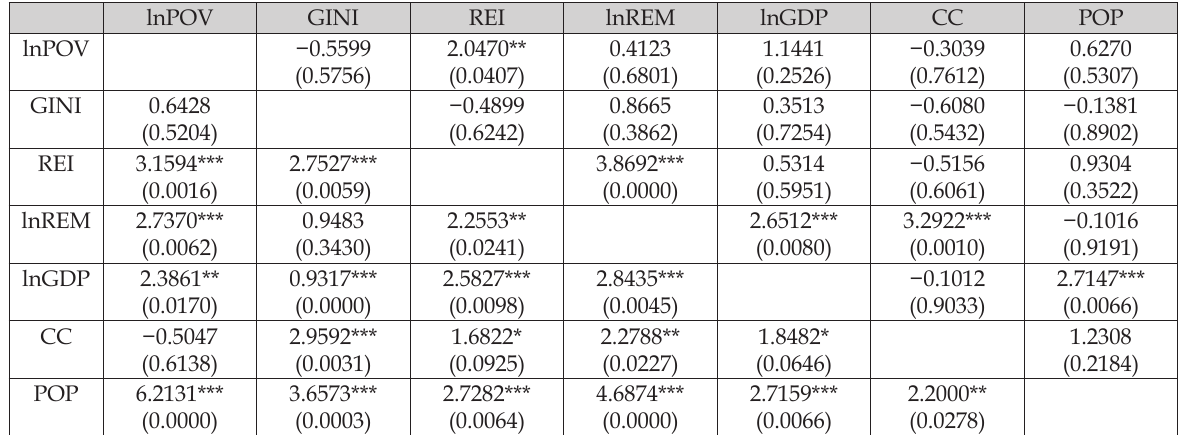
Table 10. Heterogeneous panel causality test